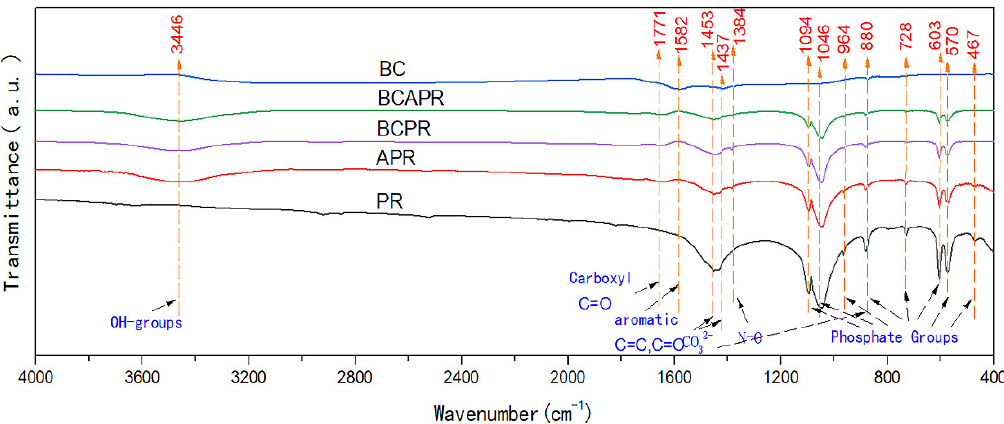
Figure 2. FTIR spectra of the different amendments. The number of replicates was three. BC: biochar, PR: phosphate rock, APR: activated phosphate rock, BCPR: composite of biochar and phosphate rock, BCAPR: composite of biochar and activated phosphate rock.